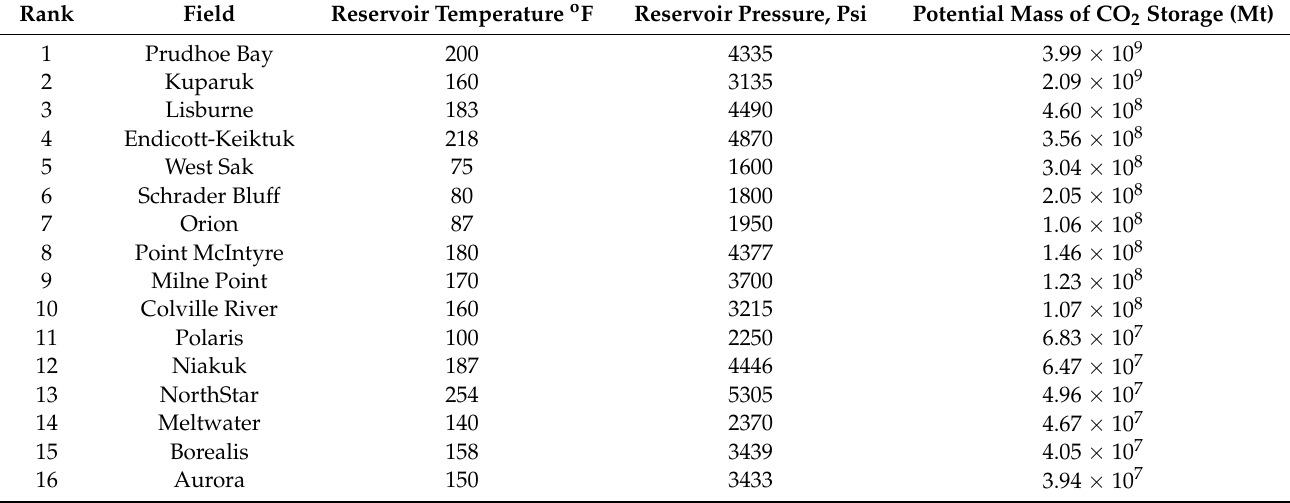
Table 5. CO 2 sequestration Ranking for Alaskan Oil Pools When Pressurized to Original Reservoir Pressures, adapted from